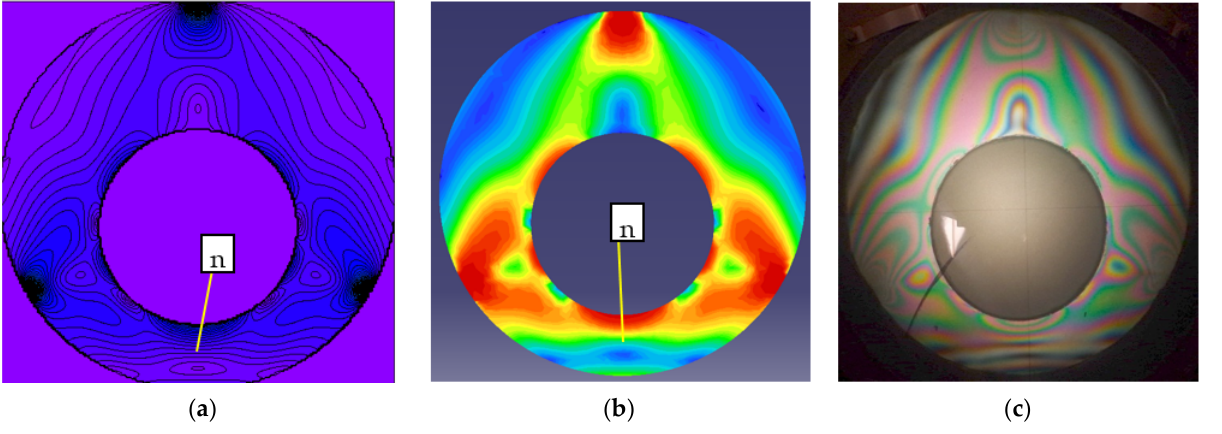
Figure 21. Isochromatic fields for the ring compressed by three equidistant forces (loading Case d, Table 1): theoretical ( a ), numerical ( b ) and experimental ( c ) results. Nuclei evidence for the theoretical ( a ) and numerical ( b ) models.